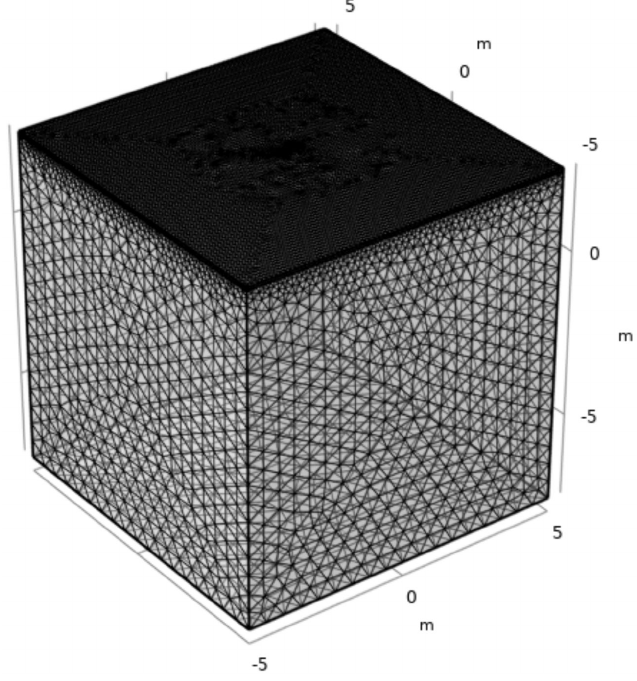
Figure 4. Tetrahedral mesh generated in COMSOL Multiphysics. Table 1. Parametric studies by varying electrode geometries and electrical resistivity mismatch ratio for the numerical simulations (a total of 48 cases are